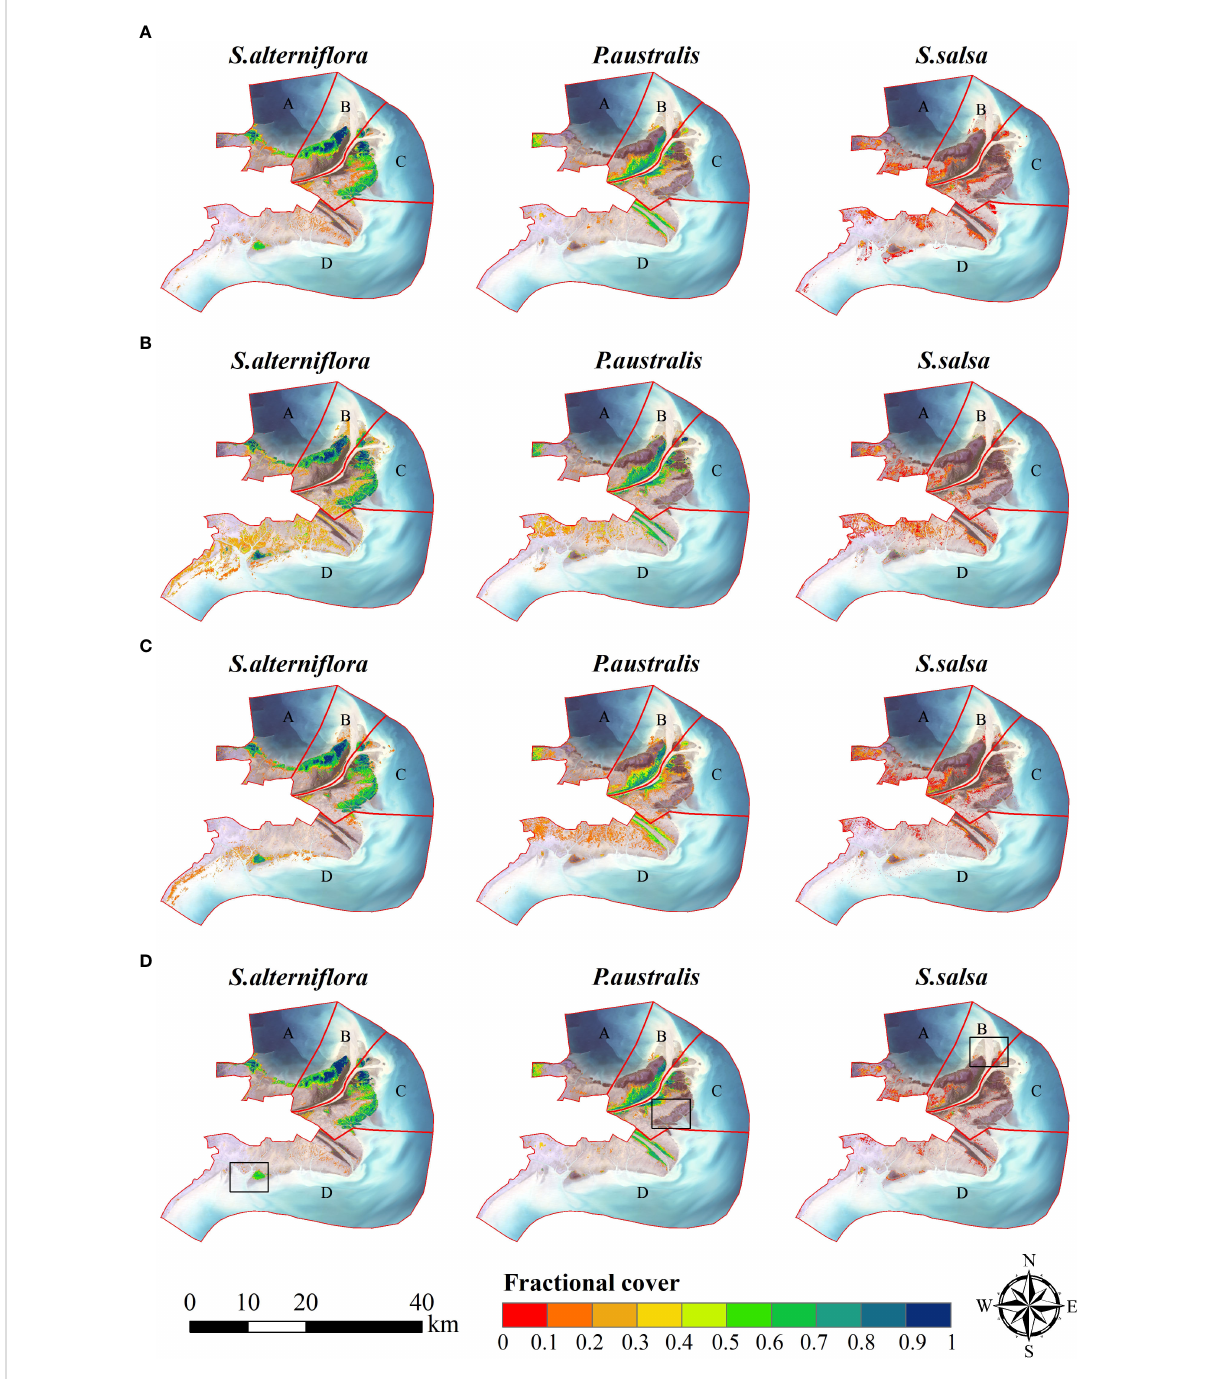
FIGURE 8 The fractional cover of three salt marsh vegetation species based on different machine learning model. (A) based on RFR; (B) based on KNNR; (C) based on GBRT and (D) based on